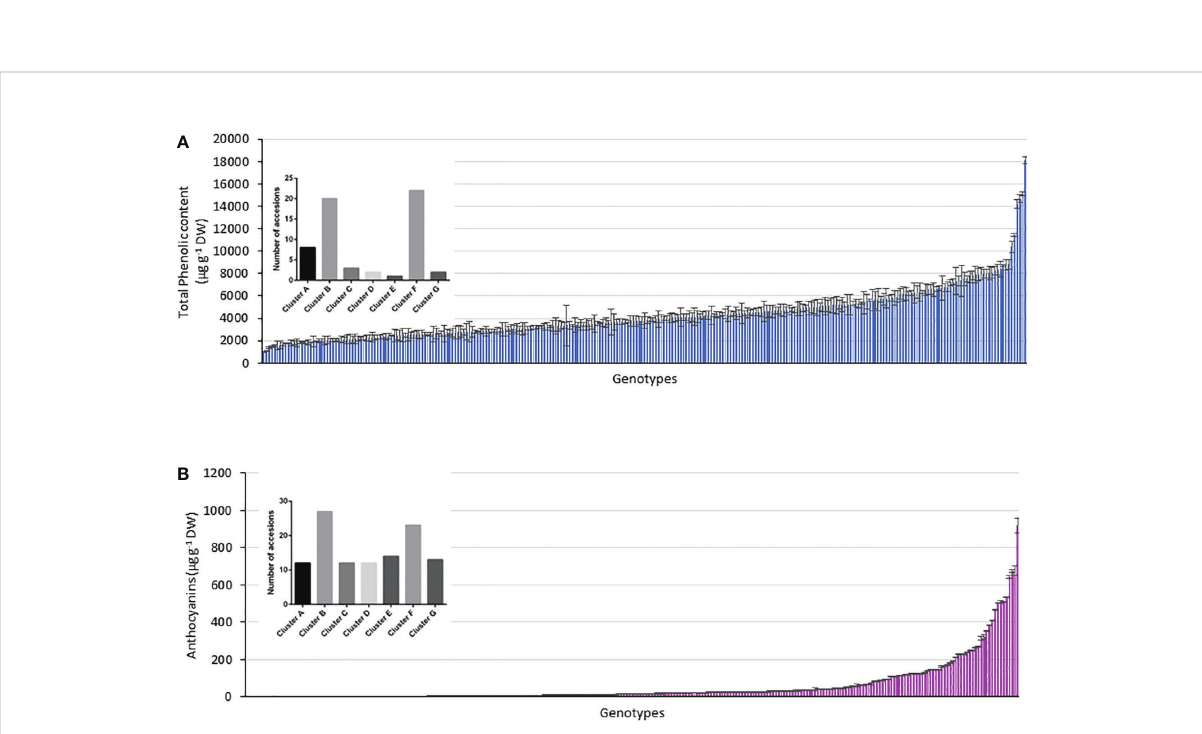
FIGURE 7 Relationship between genotype and phenotype within the accessions considering the genotypes above the respective mean values in (A) TPC, (B) anthocyanin content and the 290 accessions assigned to clusters A – G.